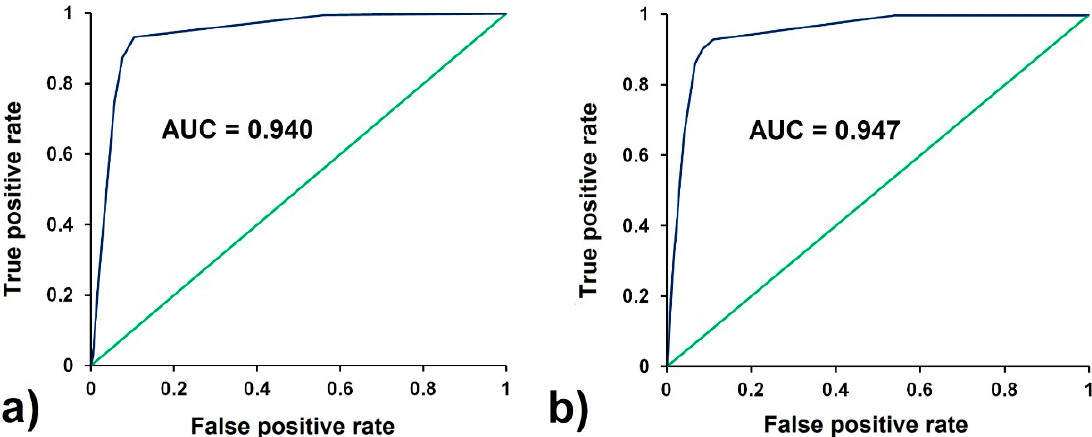
Figure 10. ROC curves carried out by the comparison between 2011 ( a ) and 2013 ( b ) final FS maps and the corresponding landslide inventory maps. Table 4. Number of correct and false predictions resulting from TRIGRS simulations for the 2011 event.